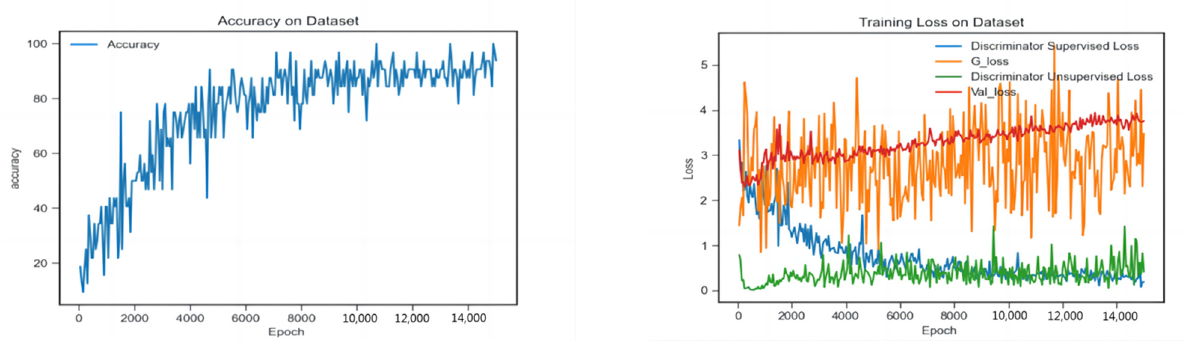
Figure 4. The model’s performance, accuracy ( left ) and training loss ( right ) on the X-ray dataset.